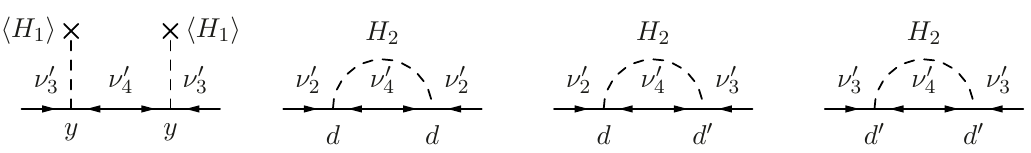
Figure 2. Diagrams, contributing to the ˆΣ mass matrix. Arrows show the flow of